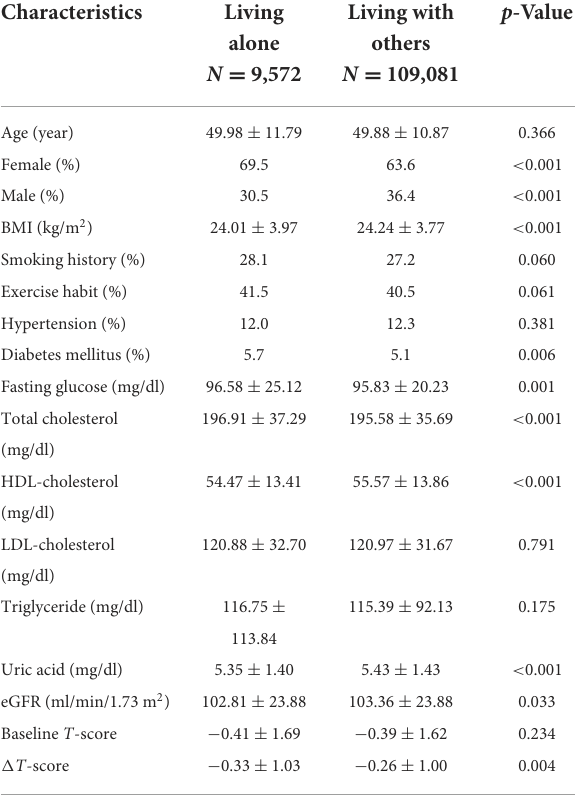
TABLE 1 Comparison of clinical characteristics among participants according to living condition. Characteristics